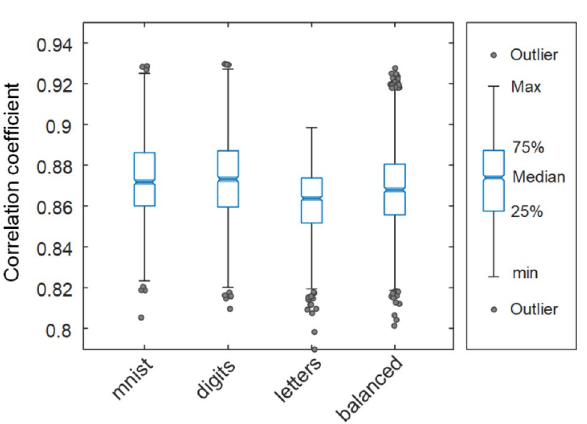
Figure 5. Statistic evaluation of the fidelity by box plots for different types of CoreNet output images. The image correlation coefficients are calculated from the numerically reconstructed images and the original target images in over 1000 random